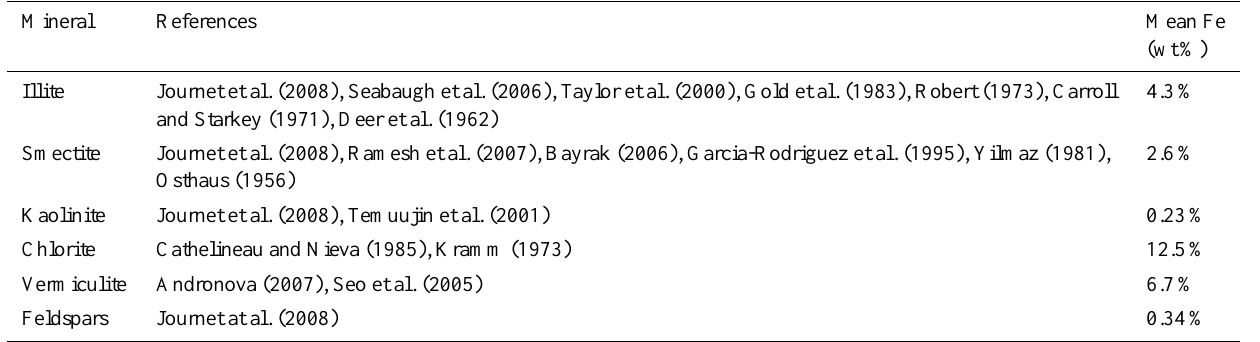
Table 2. Average iron content in selected